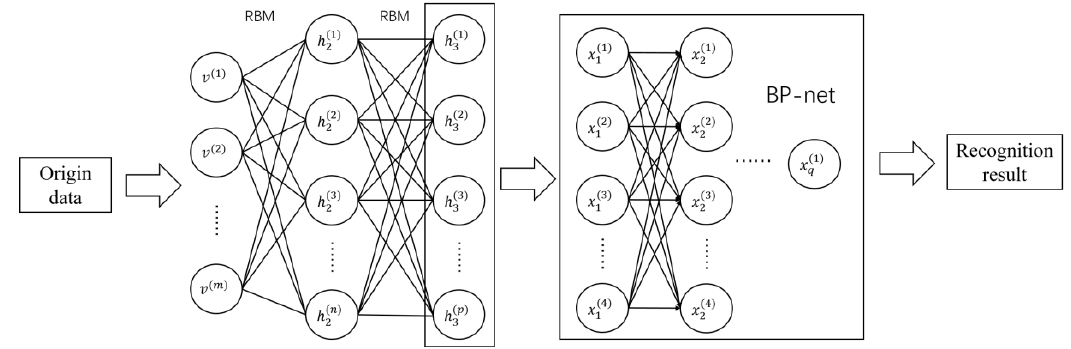
Figure 8. Deep clustering system structure.